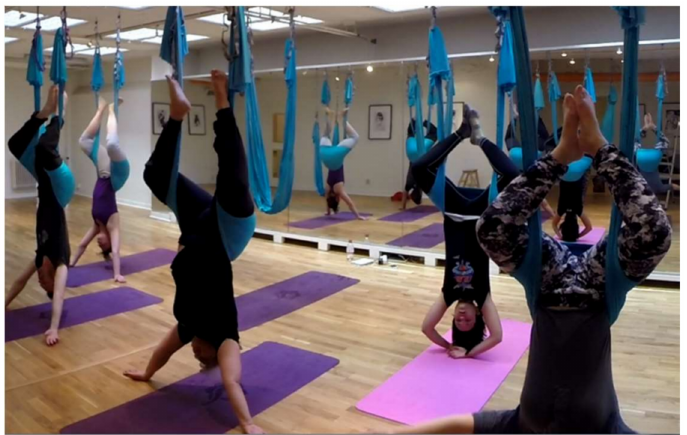
Figure 10. Screenshot of the raw video data of the sensitizing designers workshop. In this image, the designer-researchers are in an inversion pose, hanging from the